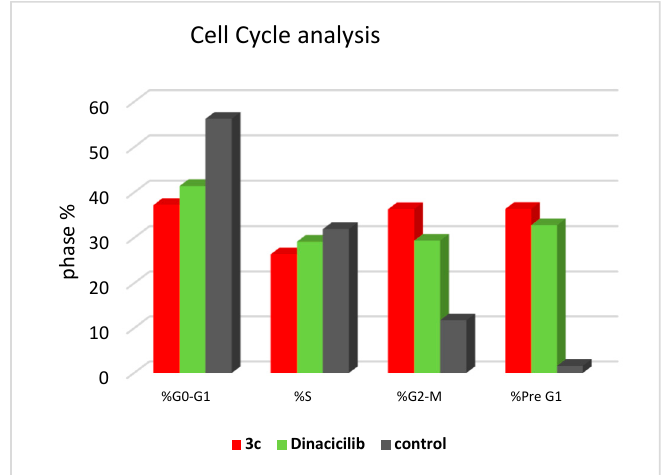
Figure 10. Cell cycle analysis on the SK-MEL-5 melanoma cell line treated with the compound.